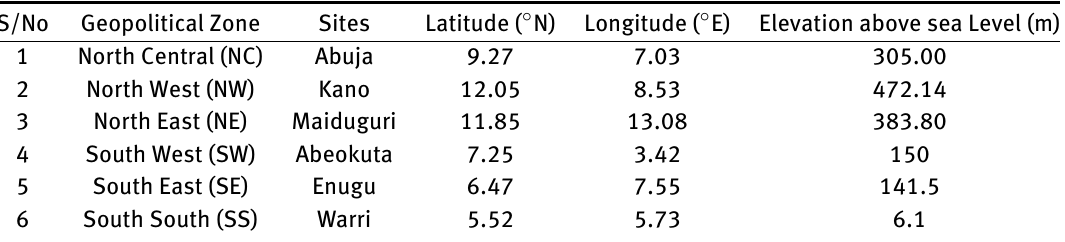
Table 1: The Geographical Coordinates of the Selected Sites